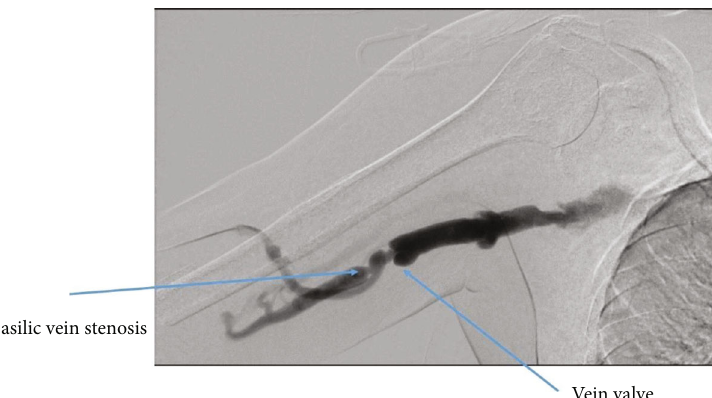
Figure 6: Relook after 2 months — self recanalization of basilic vein with signi fi cant